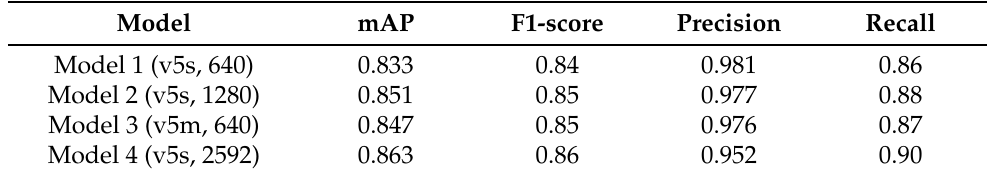
Table 2. Performance metrics of each model tested. Results were created after running inference over the validation data set. Model 1 was run using YOLOv5s, default settings, 100 epochs and 128 batch size. Model 2 was run using YOLOv5s, 1280 pixels, 100 epochs and 128 batch size. Model 3 was run using YOLOv5m, 640 resolution, 50 epochs and 128 batch size. Model 4 was run using YOLOv5s, 2592 resolution, 50 epochs and 32 batch size. Table 1 presents the mean average precision, F1-score, precision and recall of each